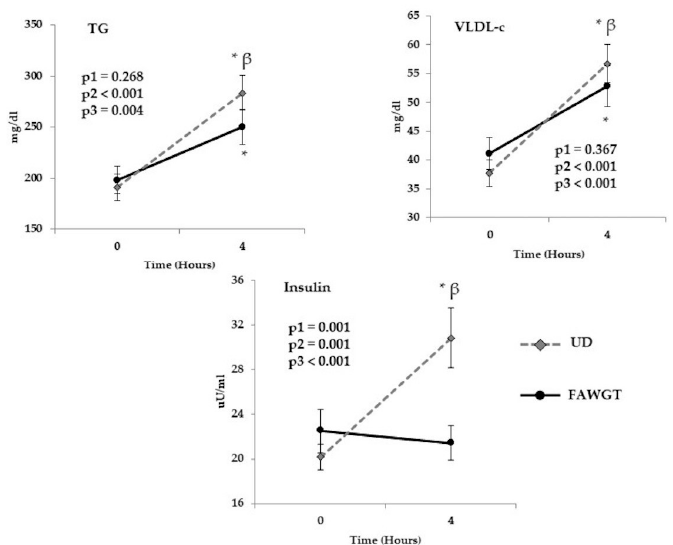
Figure 2. Acute postprandial effect of dietary intervention. Results correspond to the postprandial study performed on the first day of each dietary period. Values are shown as mean ± S.E.M, and the analysis corresponds to an ANOVA of repeated measurements, where p1 = diet influence; p2 = time, kinetics after 4 h; and p3 = the interaction of the two factors (diet vs. time). * p < 0.05 = 4 h after breakfast compared to fasting. β = p < 0.05 FAWGT vs. UD. FAWGT: diet based on fruit, avocado, whole grains, and trout; UD: usual diet.; TG: triglycerides; VLDL-c; very low-density lipoproteins.